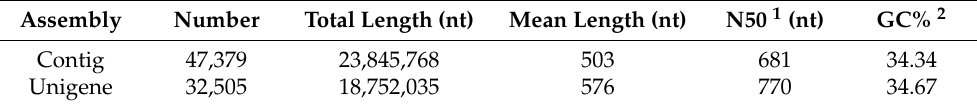
Table 2. Summary statistics of assembly for L. geometricus venom gland transcriptome.